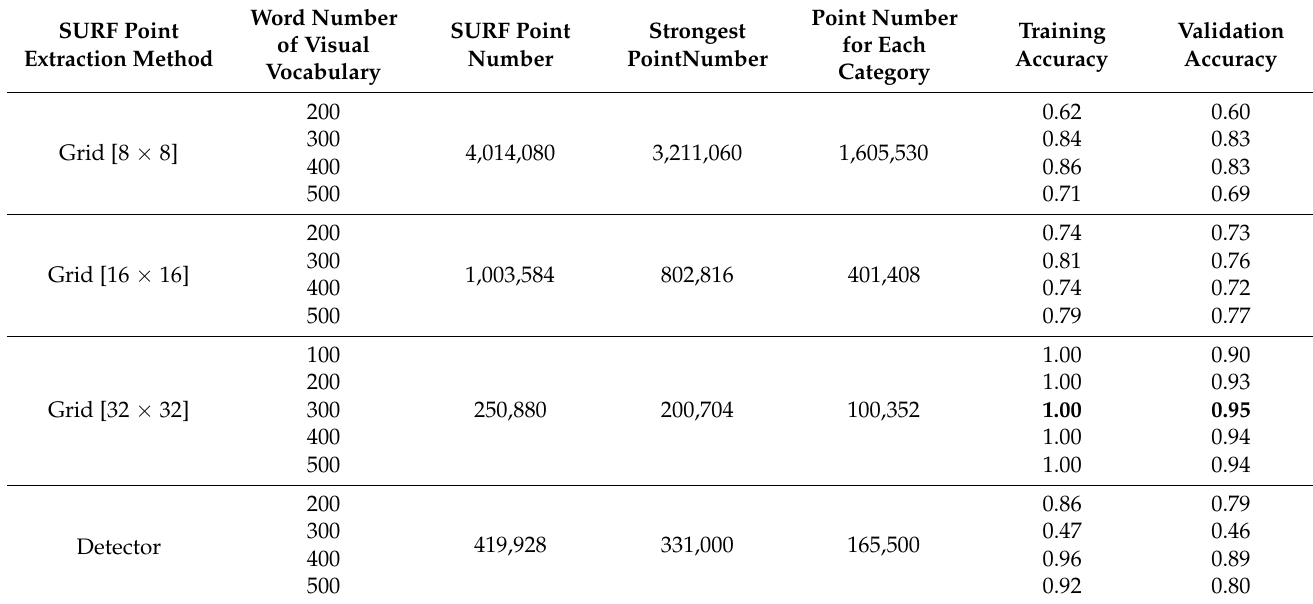
Table 3. Parameter selection in constructing visual